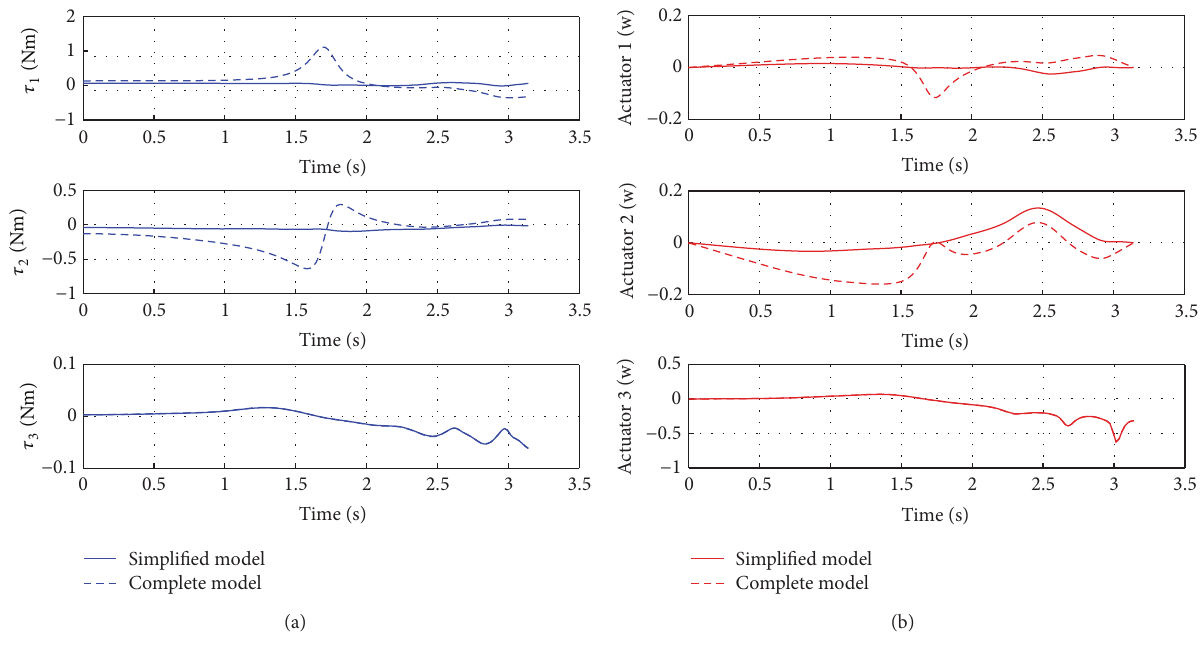
Figure 8: The dynamic simulation results of trajectory 1: (a) actuator torque; (b) actuator